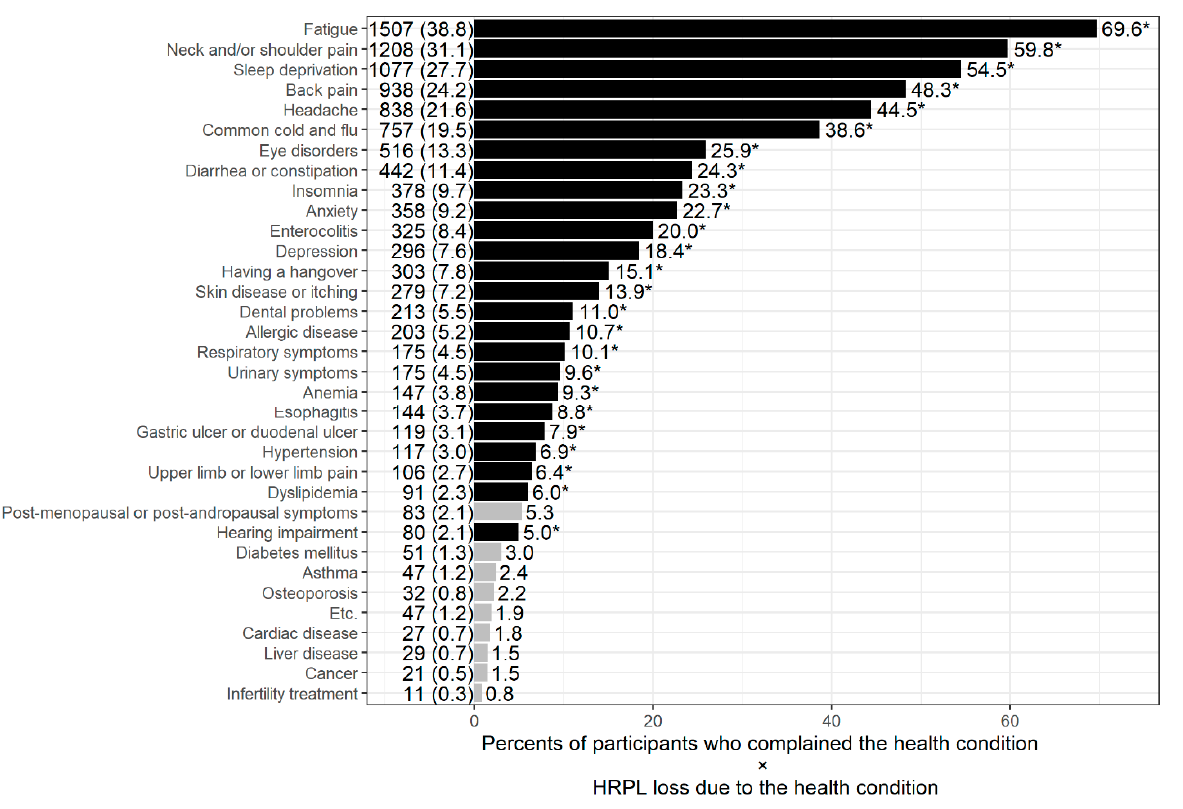
Figure 2. Work impairment burden of health conditions compared to that of participants without any health conditions. The number and percentage of workers who complained of specific health conditions are presented on the left side of each bar plot. The ratio of HRPL loss between participants with specific health conditions and that between healthy participants (without any health conditions) was calculated with adjustment for age, gender, education level, household income, marital status, employment status and weekly working hours. * p < 0.0014 was in black.